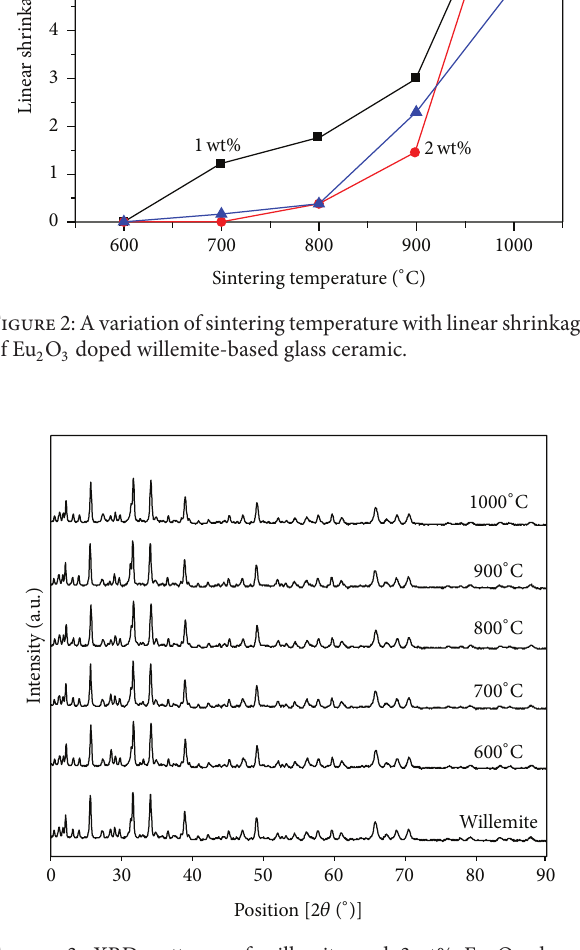
Figure 3: XRD patterns of willemite and 3 wt% Eu 2 O 3 doped willemite samples sintered at various temperatures for 4h.